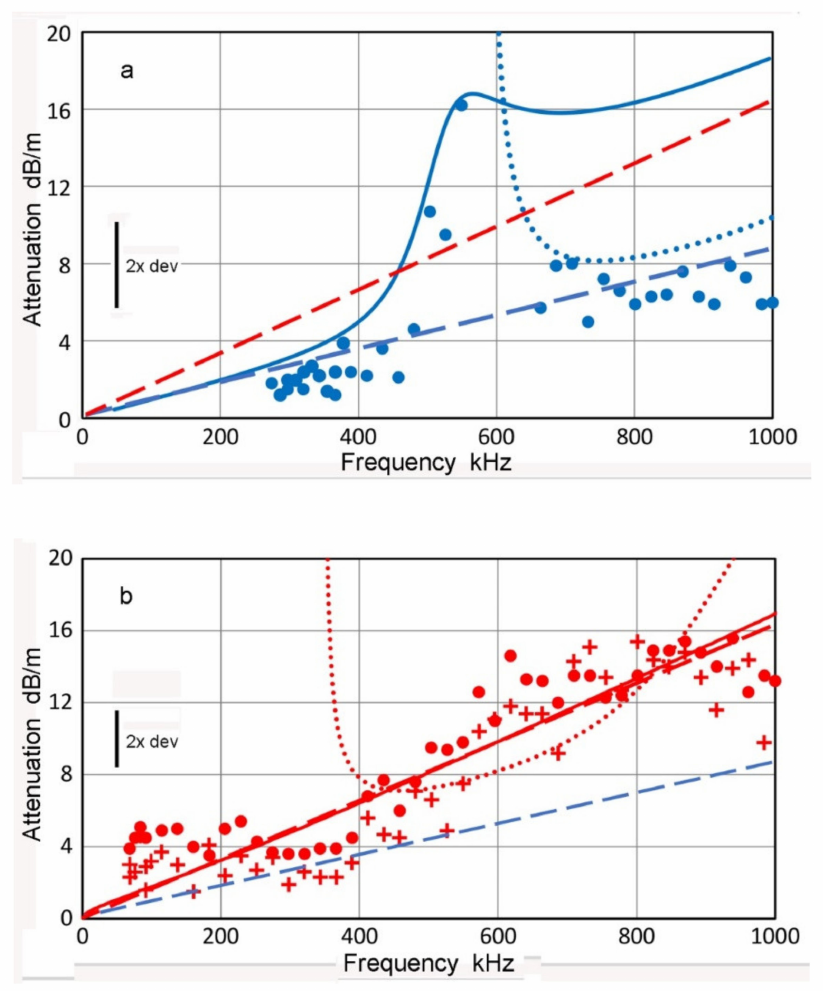
Figure 13. ( a ) α –S values for soda lime glass sheet of 4.7-mm thickness. All with Olympus V101 as Tx and KRN-BB-PC as Rx. Calculated α –S o (solid blue curve), α –S 1 (dotted blue curve), α L and α T (blue and red dashed lines) are also plotted. Vertical bar shows 2 × dev of data below 600 kHz. ( b ) Two sets of α –A o values for soda lime glass sheet of 4.7-mm thickness plotted in red symbols. Both sets used short-pulse excited NDT C16 Tx at 60 ◦ incident angle and KRN-BB-PC Rx. Calculated α –A o (solid red curve), α –A 1 (dotted red curve), α L and α T (blue and red dashed lines) are also plotted. Vertical bar shows 2 ×